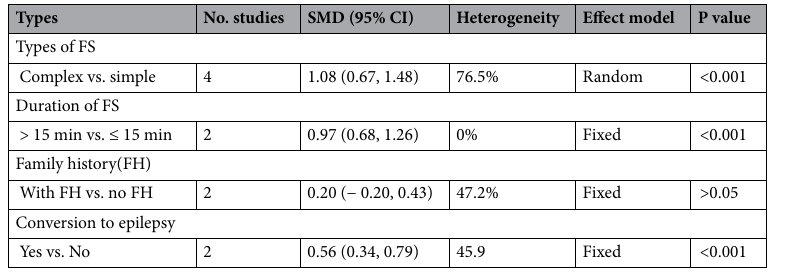
Table 2. Subgroup analysis of serum HMGB1 levels of different febrile seizure types, seizure types, seizure duration, and family history of